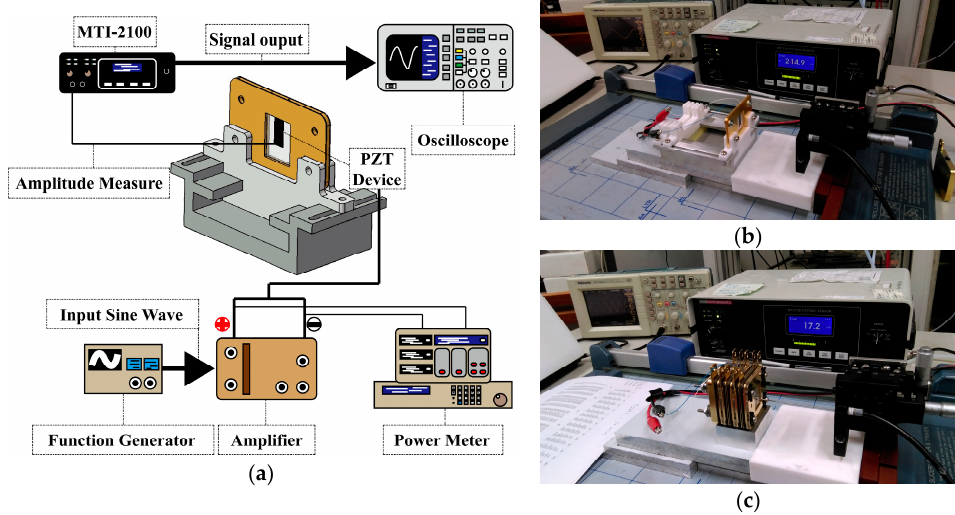
Figure 6. Resonant frequency and amplitude test system of the PZT–PDMS actuator and the PDMSmag. ( a ) Platform for experimental instruments; ( b ) Measuring the PZT–PDMS; ( c ) Measuring the PDMSmag within a stack.